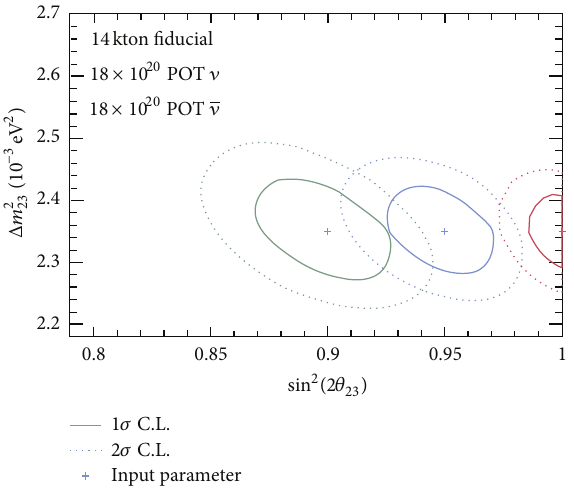
Figure 24: One and two standard deviation NO 𝜈 A sensitivity contours for a joint measurement of |Δ𝑚 2 32 | and sin 2 (2𝜃 23 ) for three possible values of these parameters indicated by the plus signs. The single parameter measurement of sin 2 (2𝜃 23 ) will be somewhat more sensitive than the extreme limits of the displayed contours.